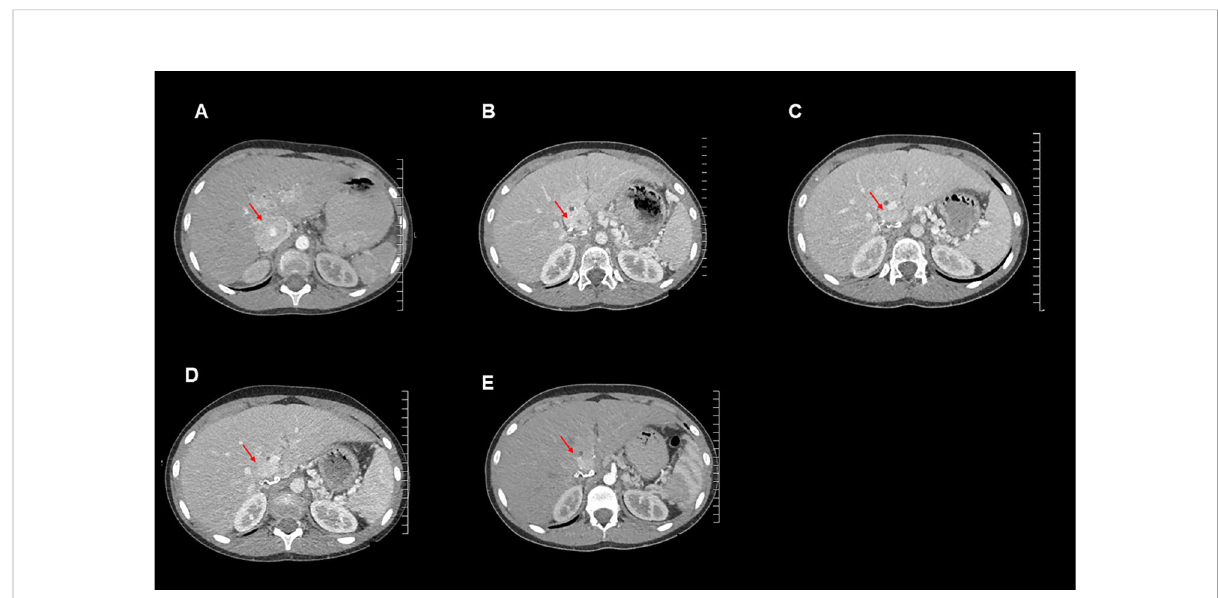
FIGURE 3 Axial contrast-enhanced CT images for this patient from the following time points: (A) : September 2020 (post operation), (B) : October 2021 (temozolomide therapy commenced), (C) : January 2022, (D) : April 2022, (E) : July 2022.